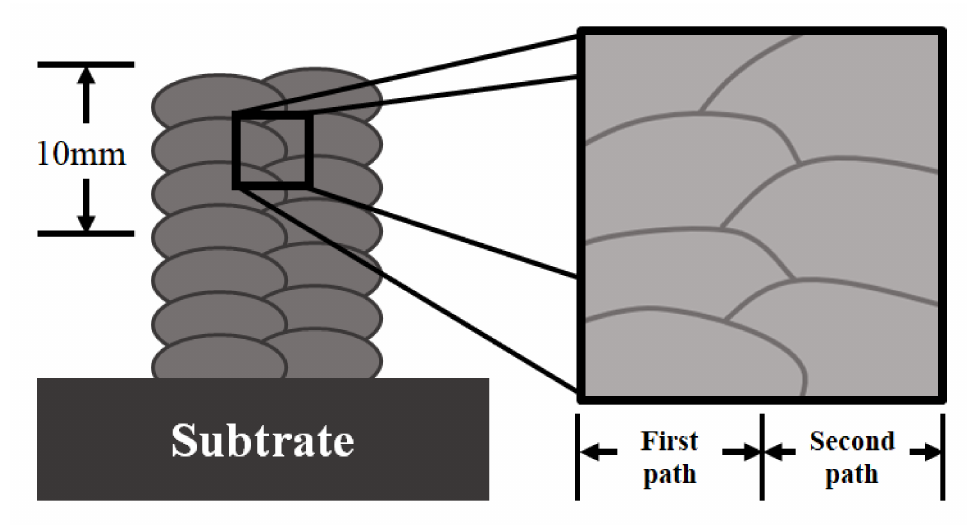
Figure 12. Schematic of measurement at the intersection parts.